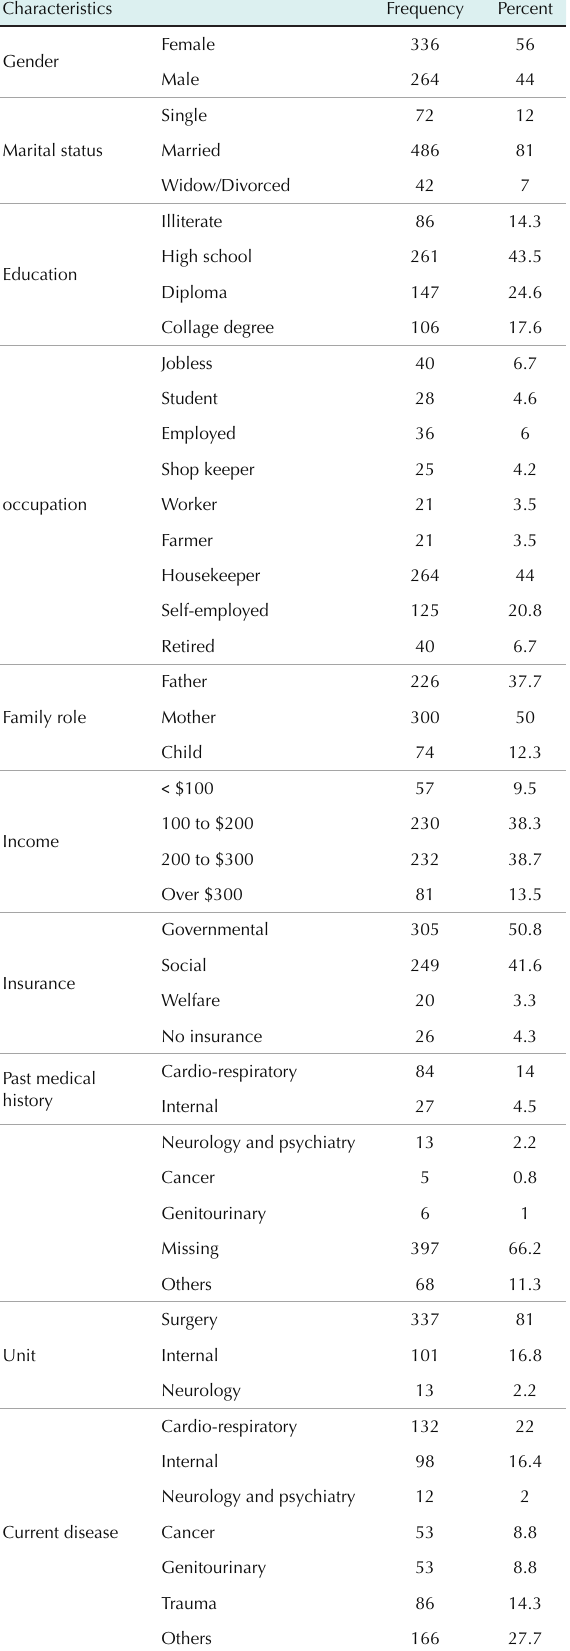
Table 1. Distribution of Demographic Characteristics